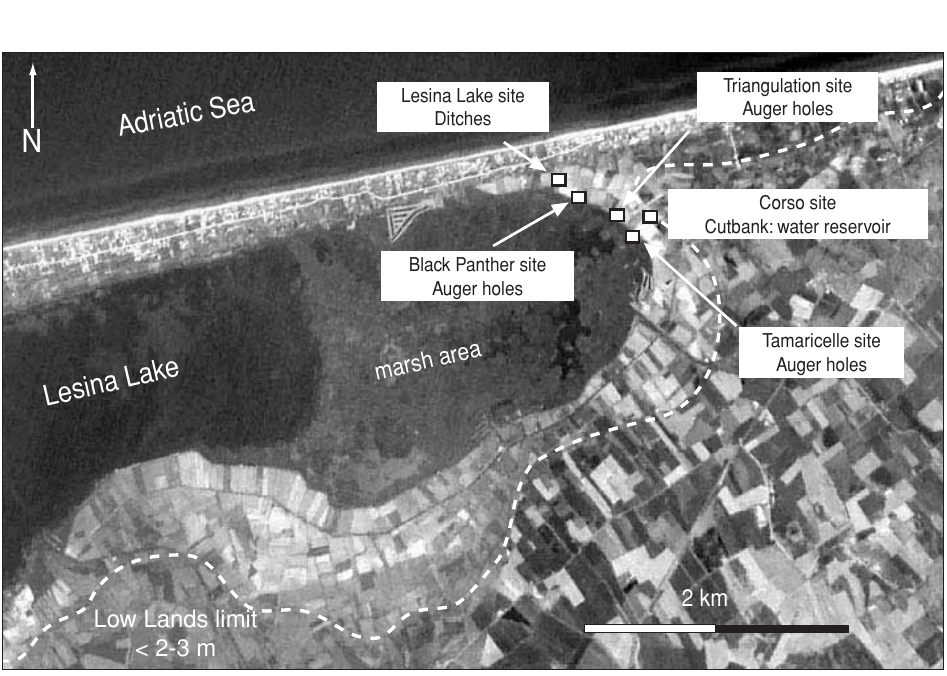
Fig. 6. Spot image (DOI-10M - National Imagery and Mapping Agency: contains data (C) CNES/SPOT image 1992-1994 copyright) of the Lesina Lake area with location the investigated sites. The dashed white line encir- cles the low lands probably inundated in